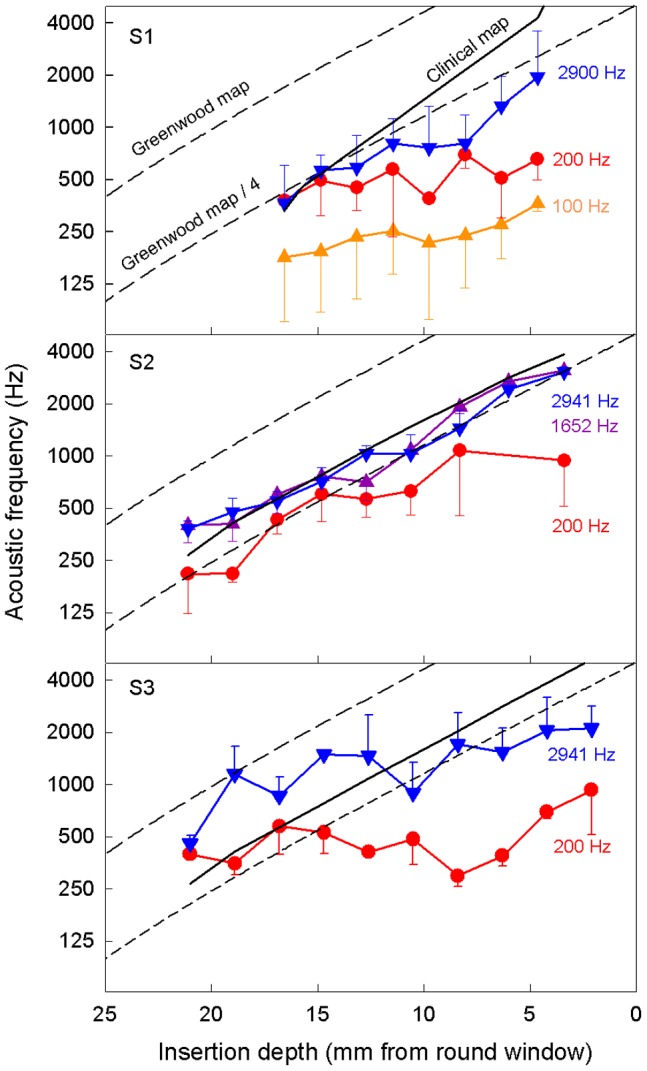
Frequency-electrode functions.The panel shows pure tone frequency matched to an electrode position for each of the 3 cochlear implant subjects with significant contralateral acoustic hearing. The x-axis is the electrode insertion depth from the round window. The y-axis is the pure-tone frequency matched to an electric stimulus delivered to a single electrode at a fixed stimulation rate (different symbols representing different rates). Error bars represent the frequency difference of two pure tones that were judged higher in pitch than the electric stimulus 50% and 70.7% of times (see text in the methods section). The upper dashed line represents the Greenwood function and the lower dashed line represents two octaves below the Greenwood function. The solid line represents the clinical frequency-electrode map used in the speech processor (Advanced Bionics for S1; Med El for S2 and S3).